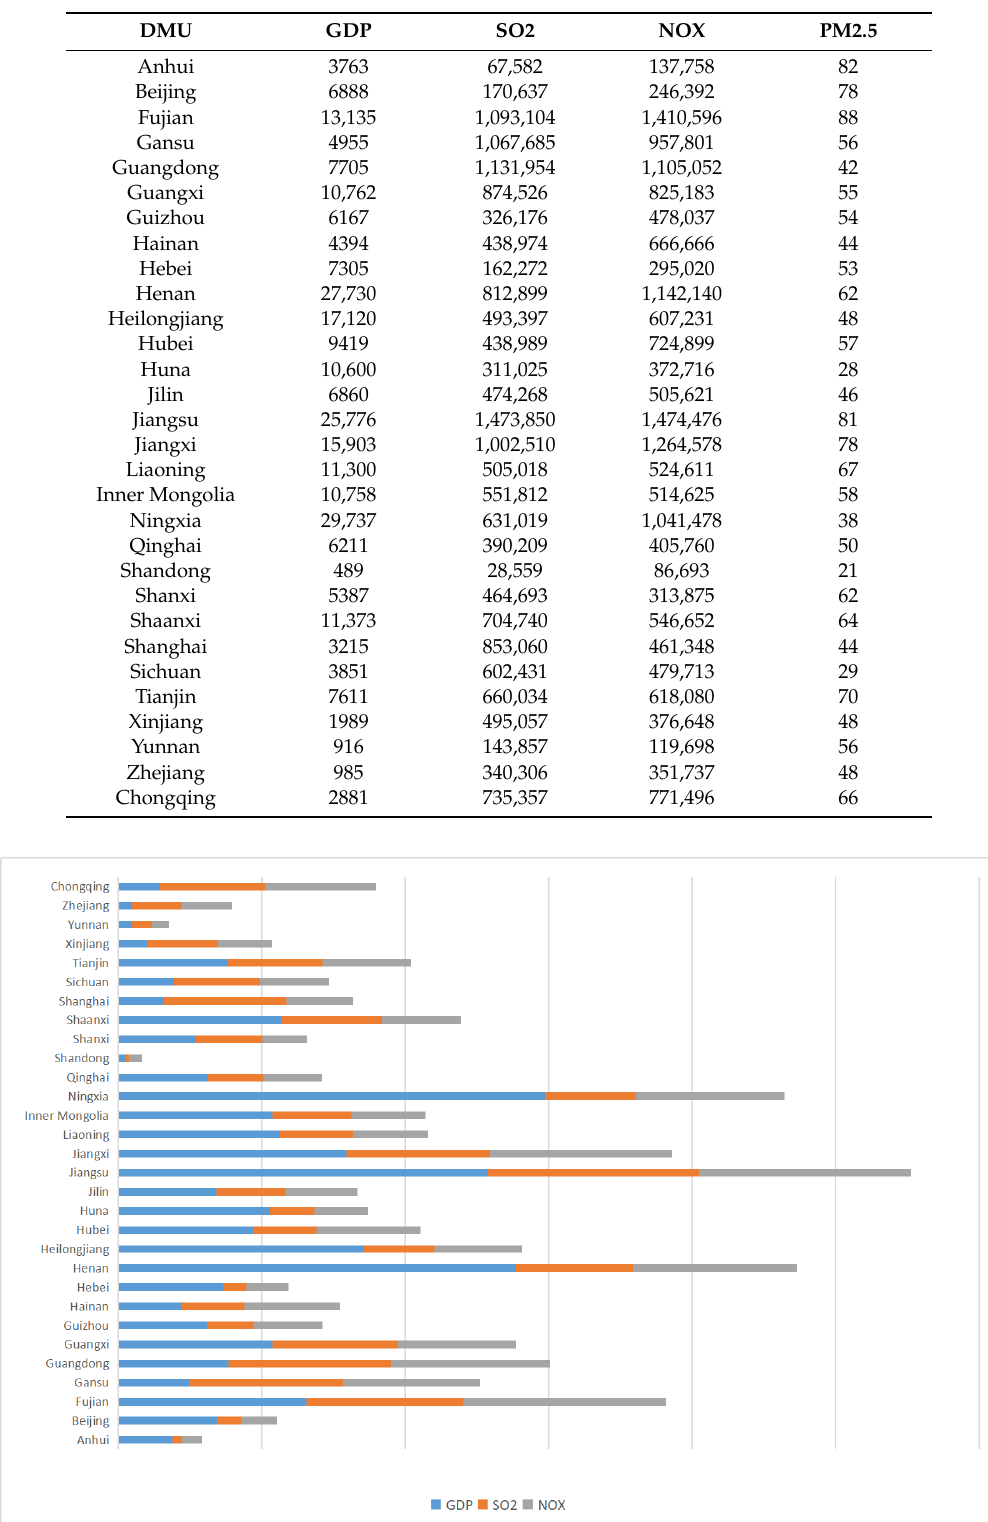
Figure A3. Comparison of the average output values of the output indicators over four years.